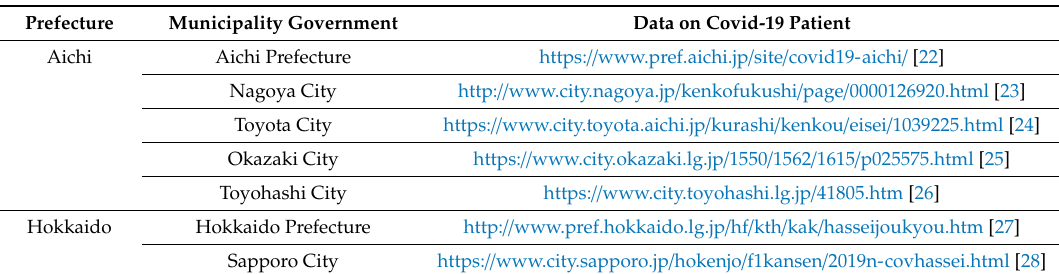
Table A1. Government’s websites for data